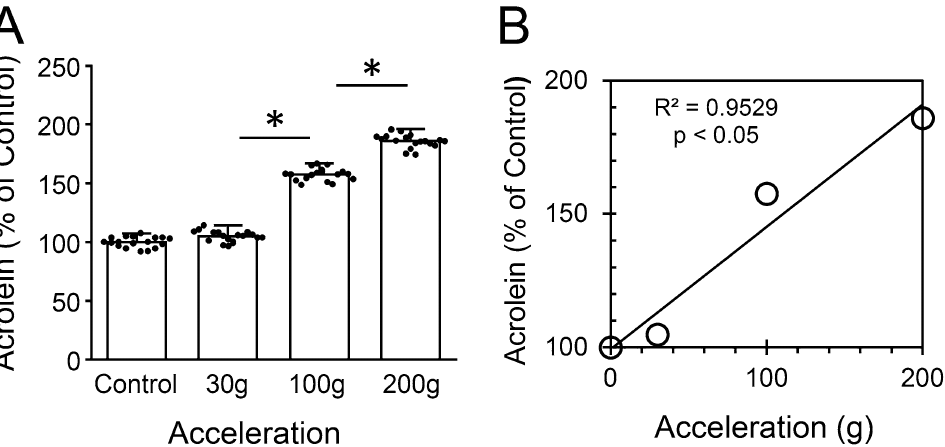
Figure 3. Quantifying the elevation of acrolein-Lys adducts as a function of single-impact severity. Immunocytochemistry (ICC) and immunofluorescence were used to detect and quantify acrolein-Lys adducts in histiotypical neuronal networks at 24 h post-impact, and compared with non-impacted, procedurally and age matched control-networks. ( A ) Average intensity measurements for Acrolein-Lys adducts given as percent control values for single impacts of 0 (control), 30, 100, and 200 g, ( B ) with the corresponding averaged acrolein values plotted as a function of acceleration to better illustrate this relationship (R 2 = 0.95, p < 0.05). Staining intensity is shown as % control values ± SD (n = 18). One-way ANOVA and subsequent Scheffe post hoc analysis were used to determine significance: * p <